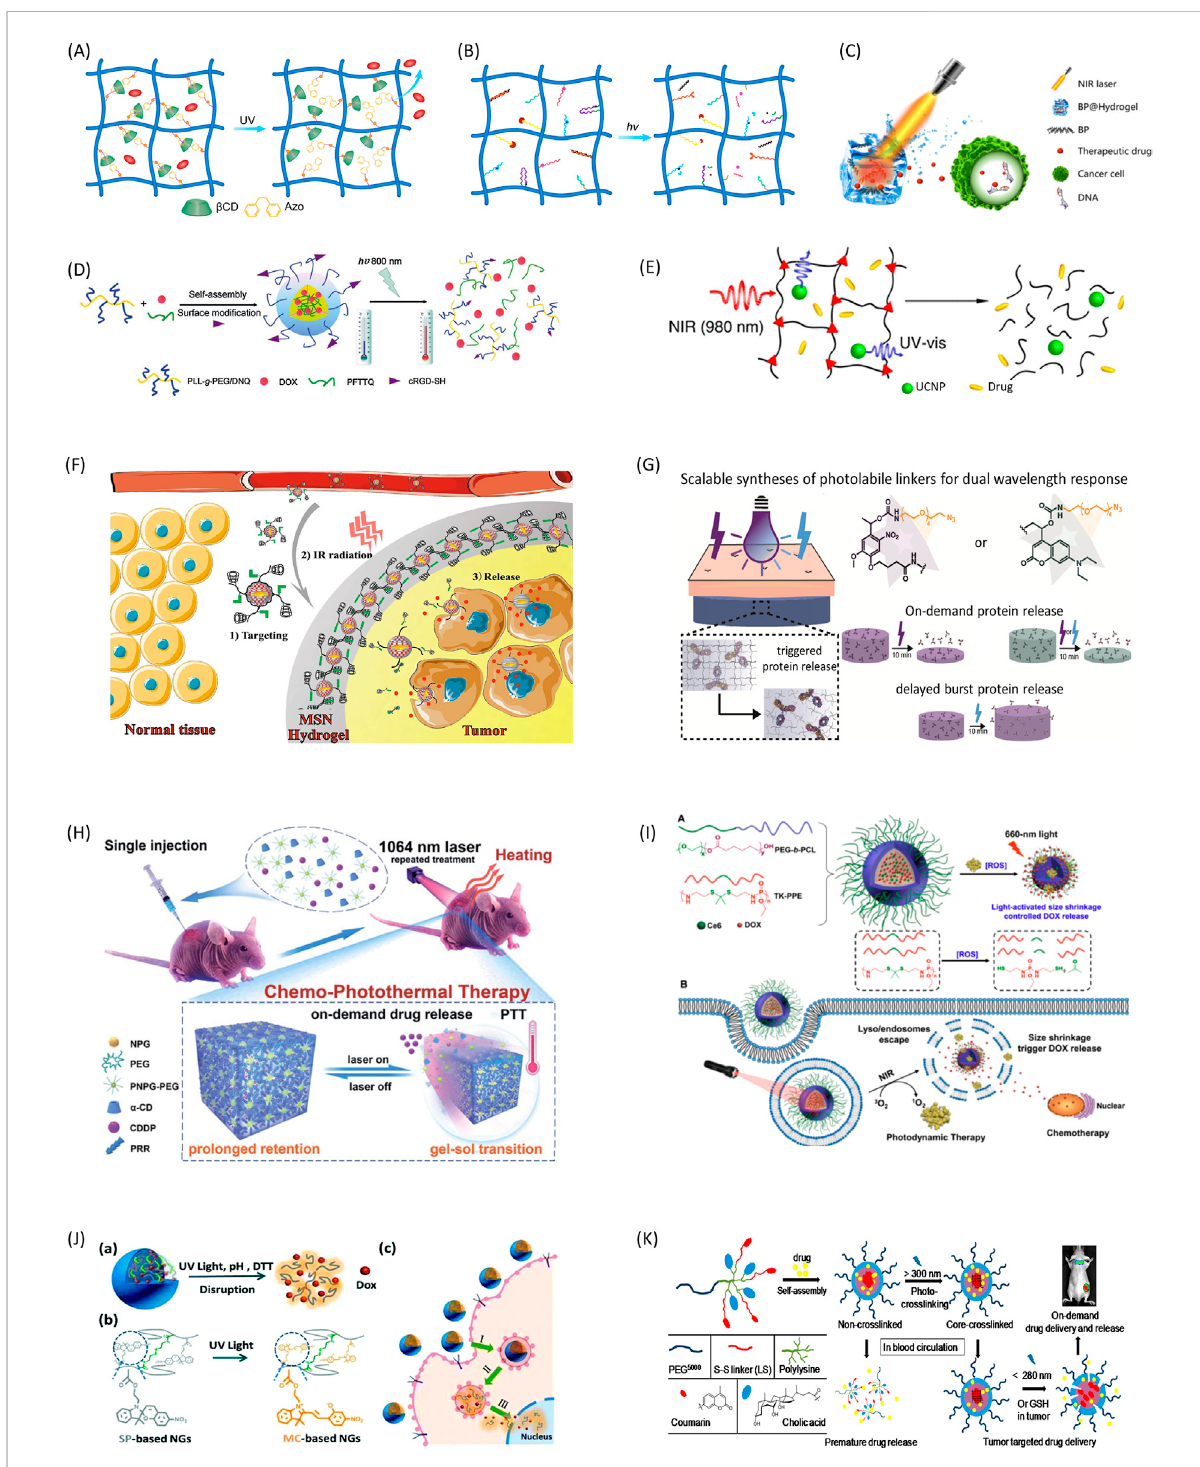
FIGURE 1 Representative mechanisms and applications of light-controlled drug delivery systems. (A) Photoisomerization induced drug release through guest-host interactions. (B) Photocleavageinduced drug releasethroughmultimechanisms. (C) Photothermaleffect-induceddrug release tobreak DNA chains. Copyright Qiu et al. (2018) NAS. (D) Two-photon light regulated chemo-photothermal therapy with fast drug release. Used